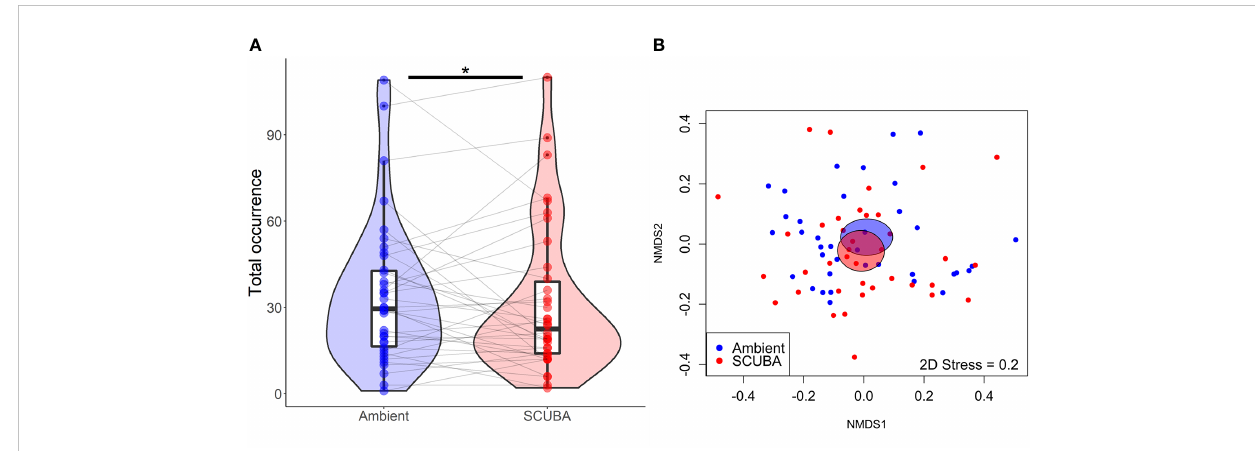
FIGURE 3 Community-level differences in total fi sh occurrence between the two acoustic treatments (playback of ambient sound or SCUBA noise). (A) Total fi sh occurrence. Boxes show median and interquartile range; violin plots show the kernel probability density of the data at different values; coloured points show treatment responses; grey lines join paired data from the same cleaning stations. * p < 0.05. N = 39 cleaning stations. (B) Nonmetric multidimensional scaling (nMDS) ordination showing variation in fi sh community. Individual dots show replicates at cleaning stations (n = 39); shaded ellipses represent the standard error of the weighted average for each treatment.